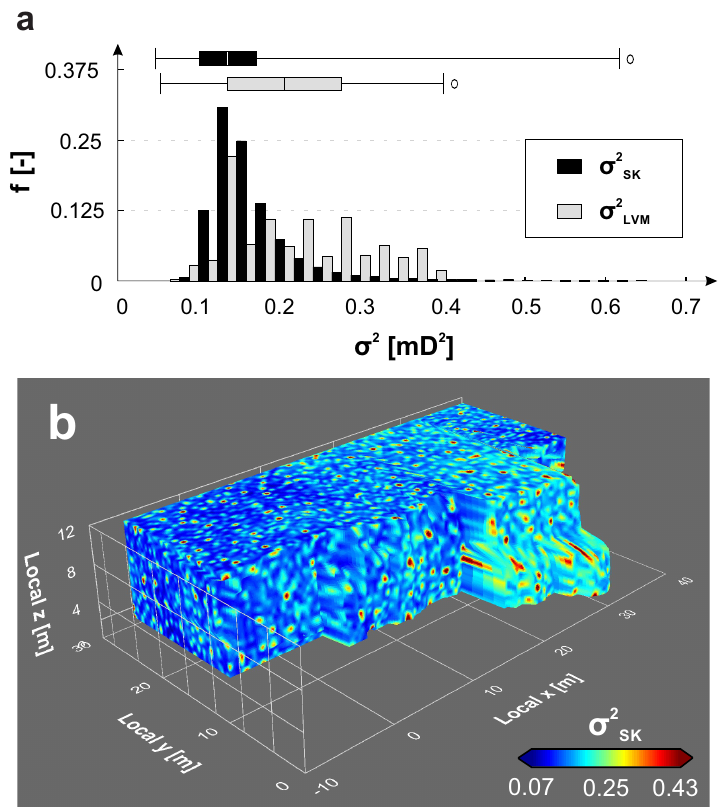
Figure 10. ( a ) Comparison of the empirical histograms of the σ 2 with the LVM and ( b ) the empirical distribution of σ 2